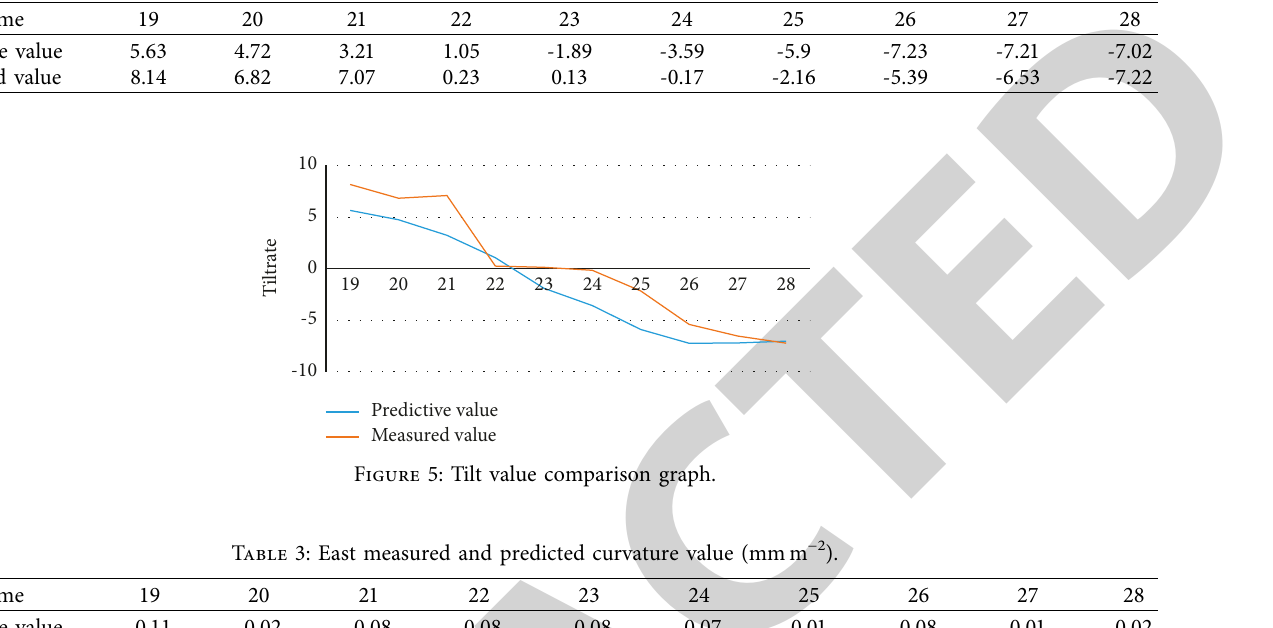
Table 2: East measured and predicted tilt value (mm ・ m − 1 ).